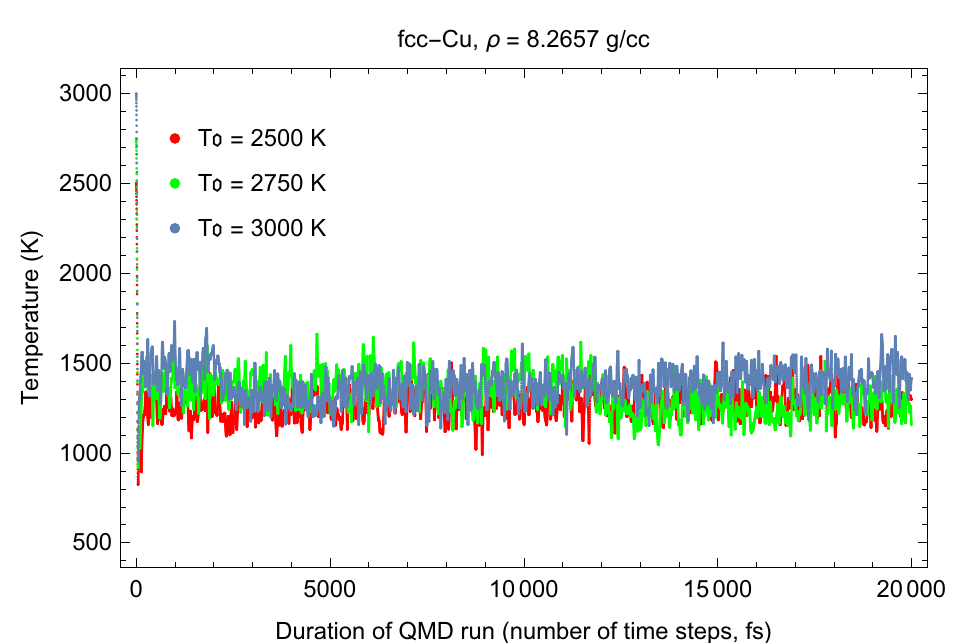
Figure 1. The melting point of fcc-Cu at a density of 8.2627 g/cc: melting T from ab initio Z method implemented with VASP.